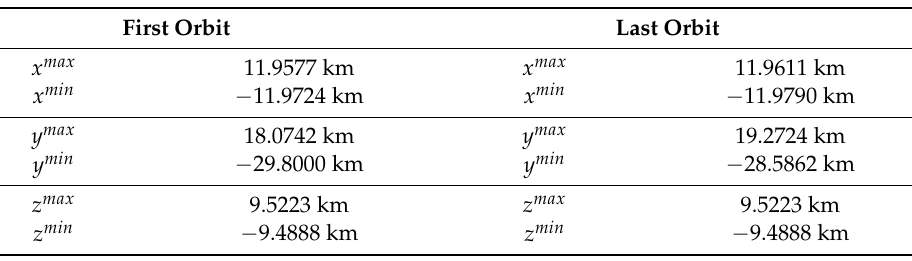
Table 6. Mid-inclination LEO formation: maximum and minimum value of the position coordinates for the first and the last orbit.